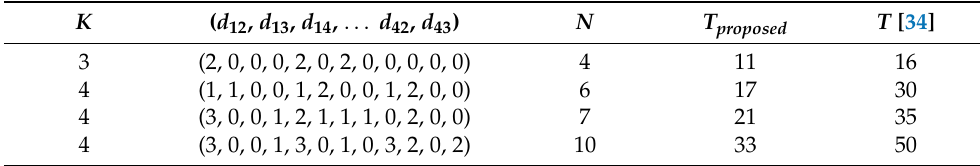
Table 5. Multicast transmission strategy based on ring